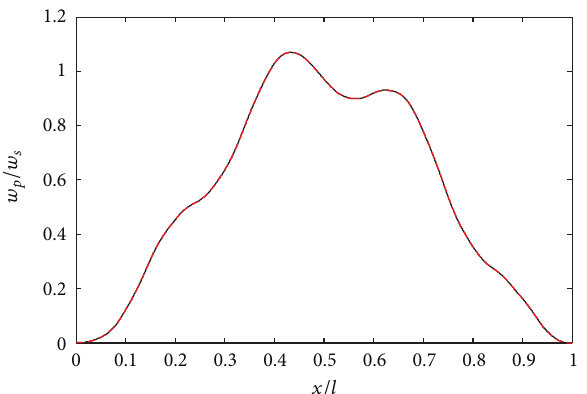
Figure 2: Instantaneous normalized lateral displacement 𝑤 𝑝 /𝑤 𝑠 under a moving mass of 𝑚 = 0.2𝜌𝐴𝑙 kg, 𝑘 1 = 10 4 N/m 2 , 𝛼 = 0.11 , and 𝛽 = 0.03 ; (—) linear analysis, present study, (.....) linear analysis, [9].